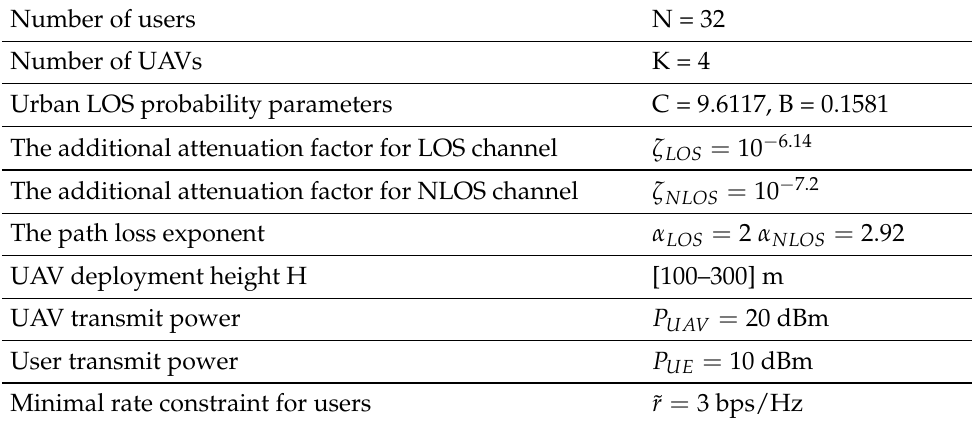
Table 1. Simulation